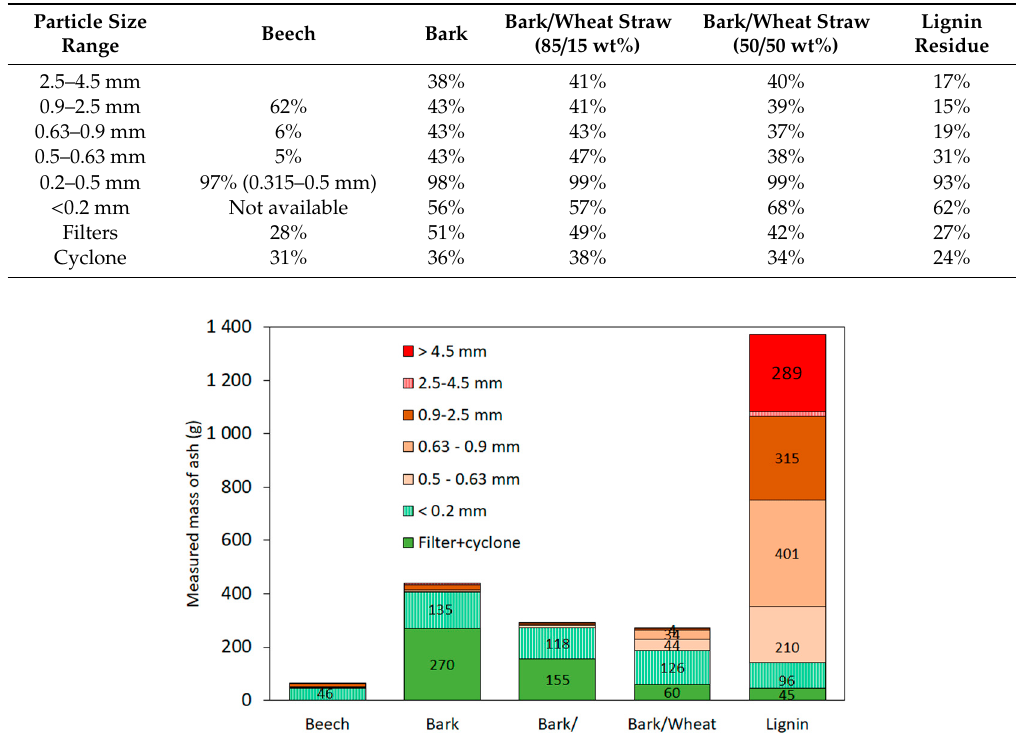
Figure 7. Mass ratio of solid residue over input dry biomass, as a function of residue particle class for each feedstock after gasification tests in fluidised bed. Table 5. Ash content (measured at 815 ◦ C) of the gasification residues according to their particle size range.